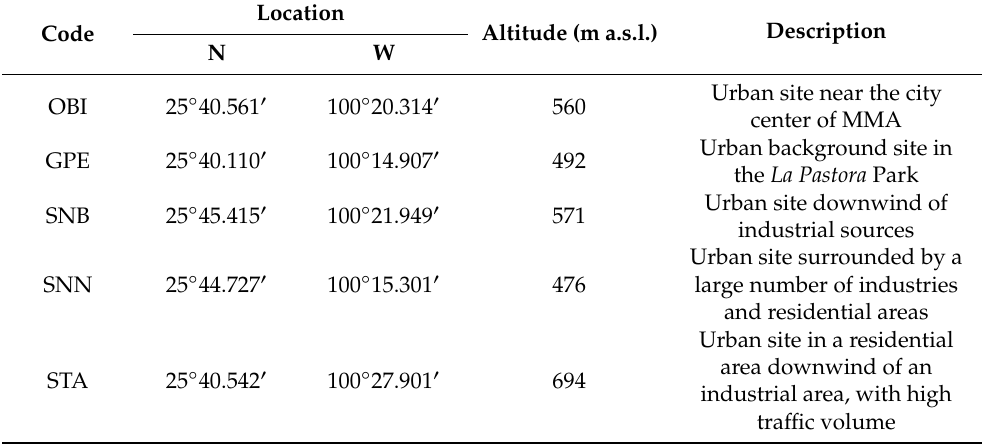
Table 1. Location and description of monitoring sites selected to conduct O 3 forecasting within the MMA. Location Altitude (m Code